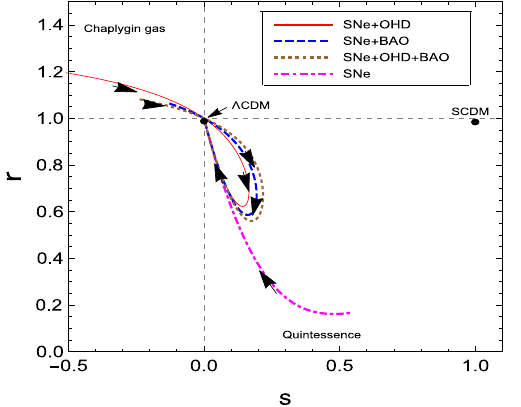
Fig. 10 The trajectory of { r , s } in s − r plane corresponds to best fitted parameters. The arrow shows the direction of the evolution of the trajectory